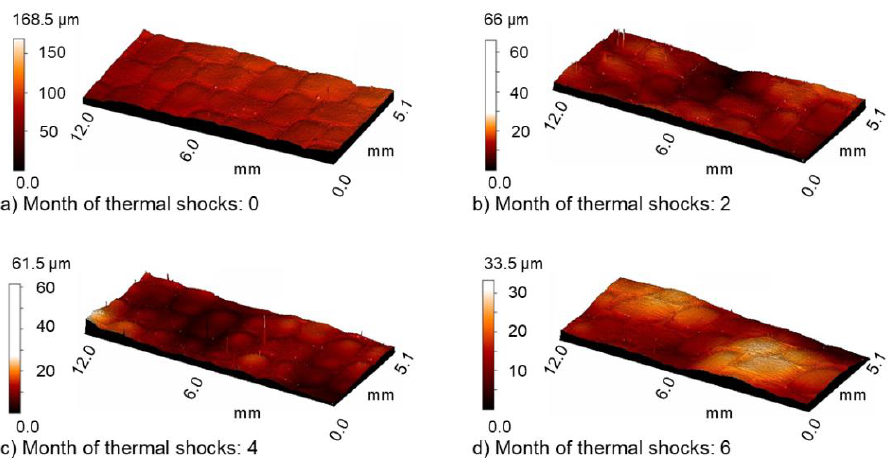
Figure 13. Surface of the examined sample prior to abrasive wear after ( a ) 0, ( b ) 2, ( c ) 4, and ( d ) 6 months of thermal shocks.